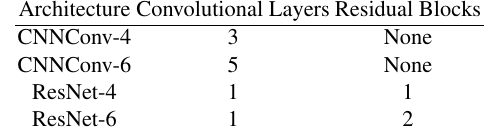
Table 1: Architecture for CNNCONV and ResNet based Deep Learning Models